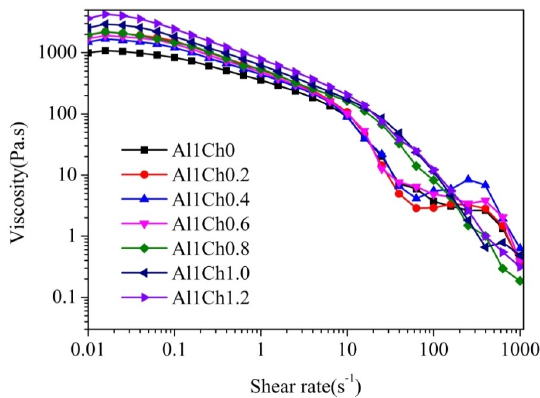
Figure 2. Rheology of 3D printing ink.